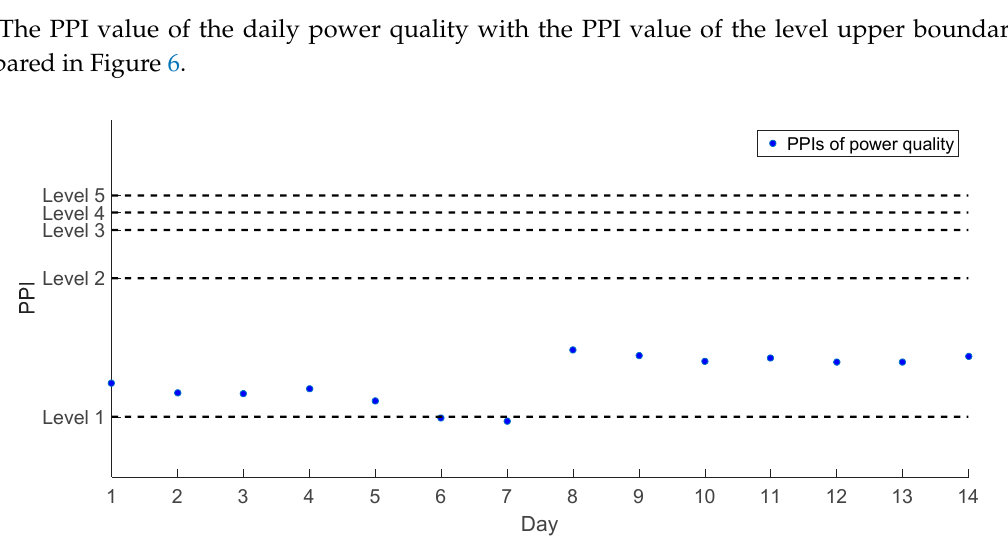
Figure 6. The results of synthetic evaluation of steady-state power quality.